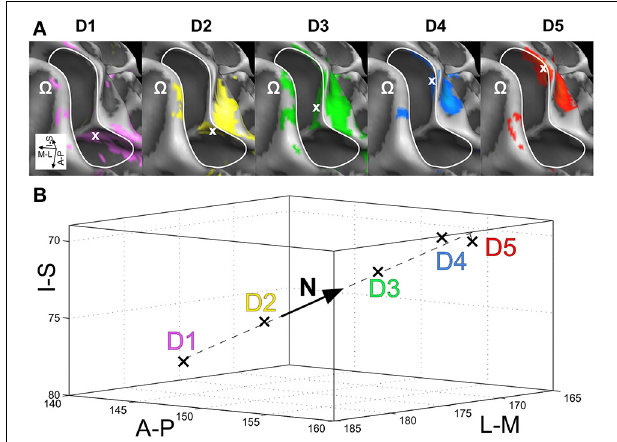
FIGURE 2 | Direction vector N (for p1 of subject S2). (A) View from above onto the surface reconstruction of an individual left hemisphere, with the motor hand knob ( (cid:2) ) in the foreground and the somatosensory BA 3b hand area in the center (A-P, anterior-posterior; M-L, medial-lateral; I-S, inferior-superior). The area used for peak–vertex analysis is marked (white border), peak vertices are marked by white crosses. From left to right, digit activations refer to D1, magenta; D2, yellow; D3, green; D4, blue; and D5, red. (B) Three-dimensional representation of the 5 peak vertices (1mm isotropic coordinates in AC–PC-oriented native space) and their best-fitting line (dashed) as direction vector N. This subject shows somatotopy as the projections of the first phalanges onto N are sequential from D1 to